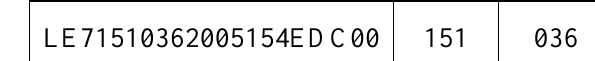
Table 1: Scenes of Landsat data used